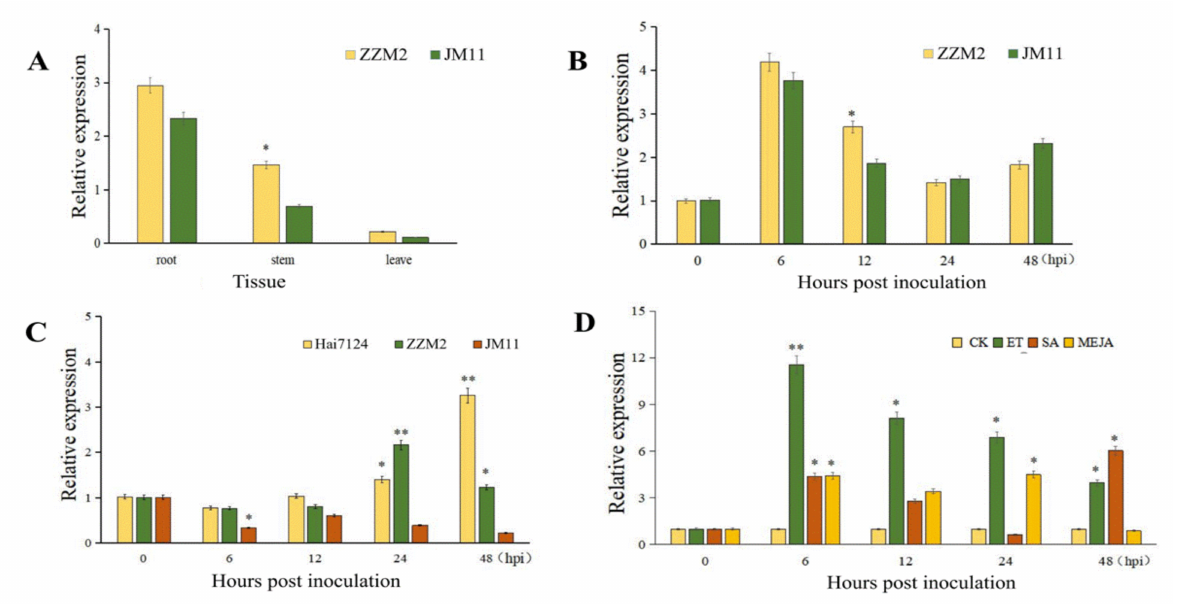
Figure 6. Expression pattern of cotton TBL34. ( A ). Tissue-specific expression of TBL34 ; ( B ). Expression levels of the TBL34 gene in stems of resistant and susceptible cultivars after inoculation with V. dahliae ; ( C ). Expression levels of the TBL34 gene in roots of resistant and susceptible cultivars after inoculation with V. dahliae ; ( D ). Expression levels of the TBL34 gene in stems of Gossypium hirsutum L. treated with different hormones. Note: CK = Control; ET = Ethylene; SA = Salicylic acid; MEJA = Jasmonic acid; The significant difference is Student ’s t test; * p < 0.05; ** p <